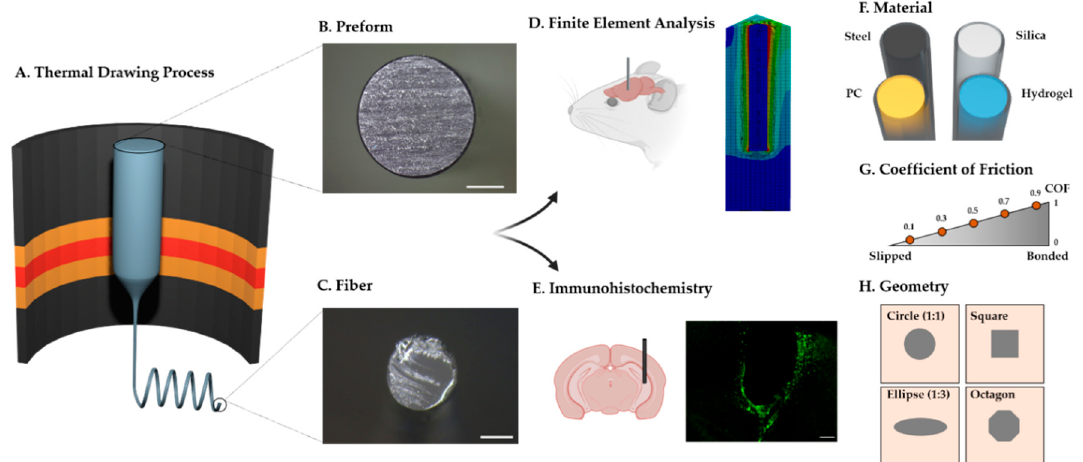
Figure 1. Schematic representation of the study. ( A ) Illustration of the fiber fabrication with the thermal drawing process (TDP). ( B , C ) Representative cross-sectional image of the preform (B) and the thermally drawn fiber (C) made of polycarbonate (the scale bar indicates 3 cm ( B ) and 200 μ m ( C )). ( D ) Finite element analysis and ( E ) histological analysis (immunohistochemistry) after the implantation of fiber implants. ( F ) Illustration of PDMS dip-coated fiber implants with four different materials; stainless steel (steel), silica, polycarbonate (PC), and HydroMed D4 (hydrogel). ( G , H ) Illustrations representing design factors considered in this study: coefficient of friction and geometry of the cross-section. In ( H ), the outer square represents the cross-section of the brain tissue, and the inner shape depicts the cross-section of the neural probe.